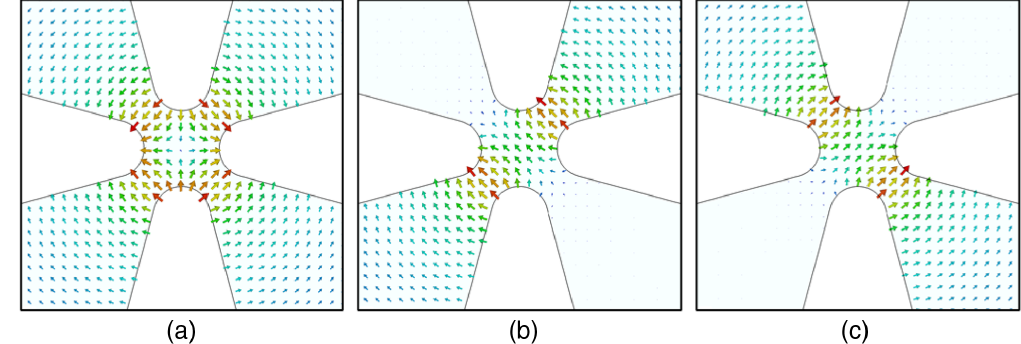
FIG. 6. Electric field patterns exist in an ideal four-vane RFQ (a: Quadrupole mode TE210; b: Dipole mode1 TE11n; c: Dipole mode2 TE11n).